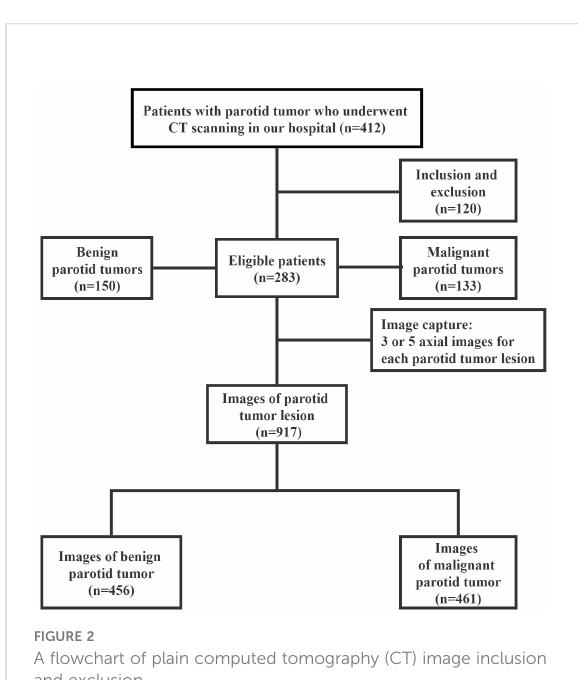
fi rst block, the image was converted into a 159 × 159 × 64 tensor. Between the second and fi fth stages, a residual block structure